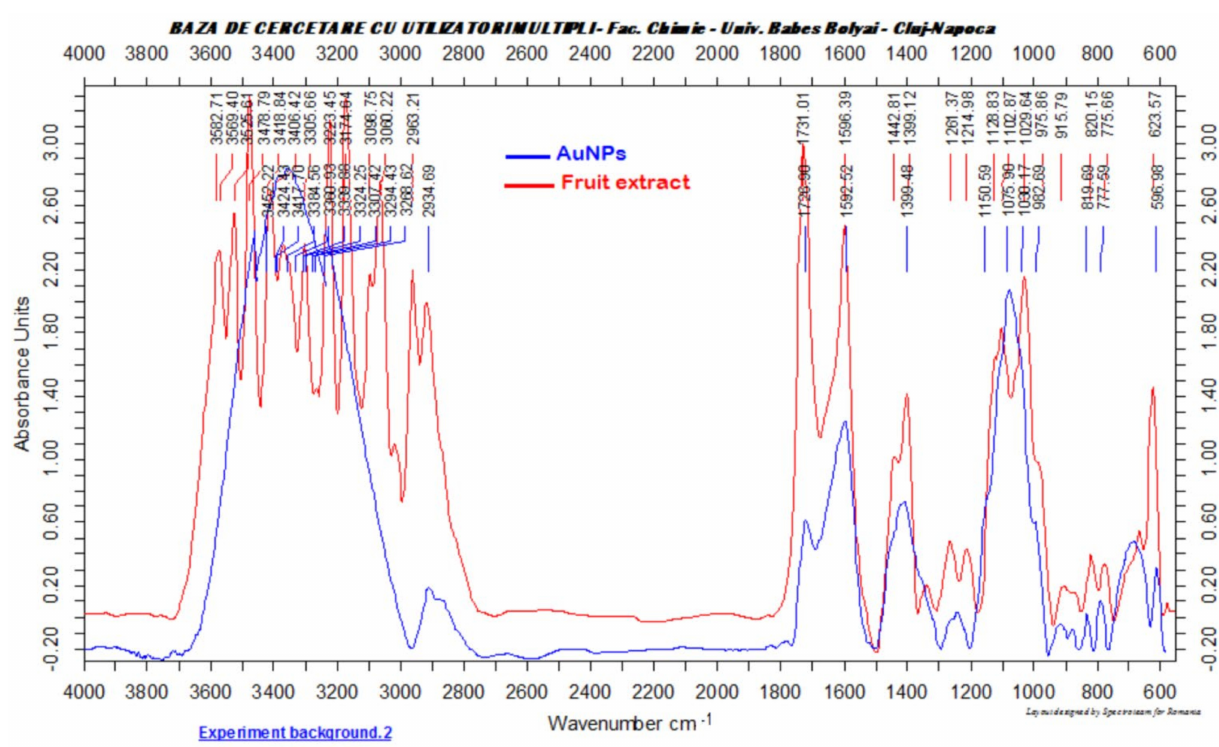
Figure 4. FTIR spectra of the obtained gold nanoparticles and biomolecules from the fruit